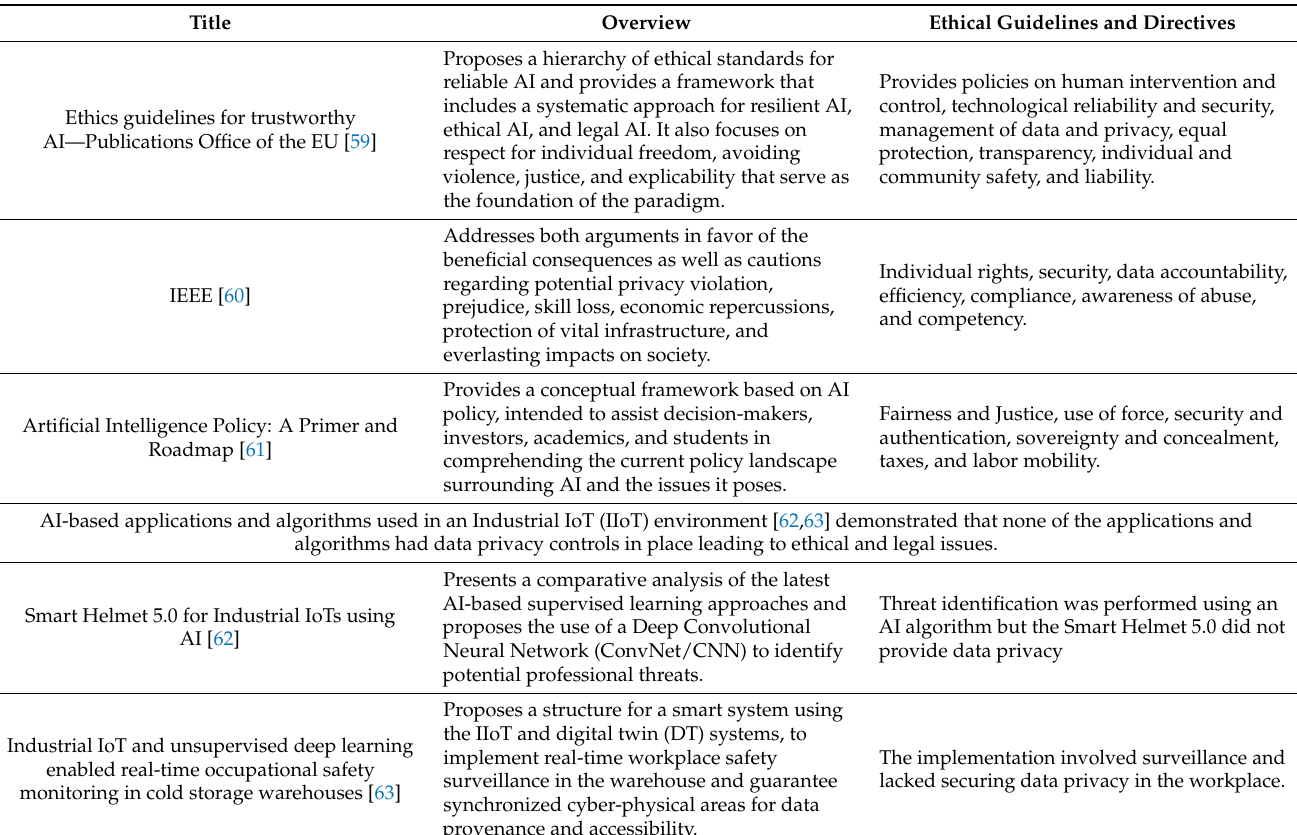
Table 4. Ethical Issues and Directives for